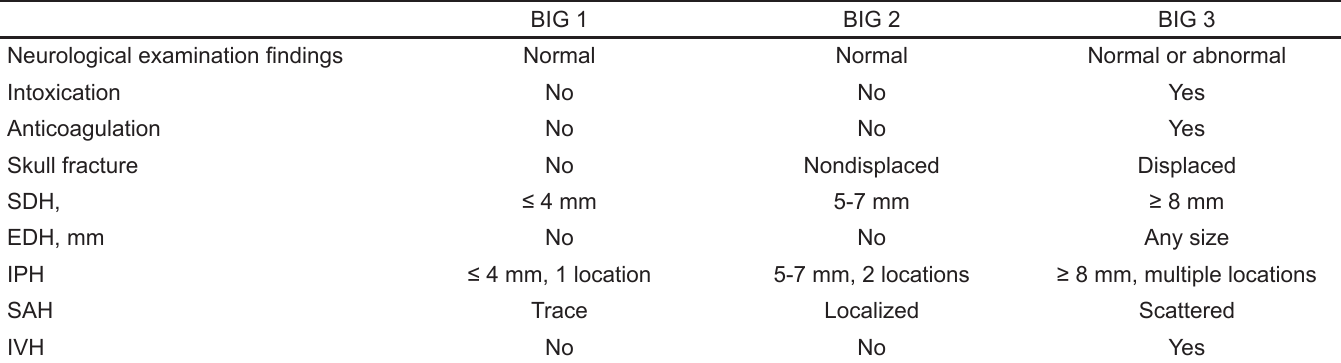
SDH , subdural hematoma; mm , millimeters; EDH , epidural hematoma; IPH , intraparenchymal hemorrhage; SAH , subarachnoid hemorrhage; IVH , intraventricular